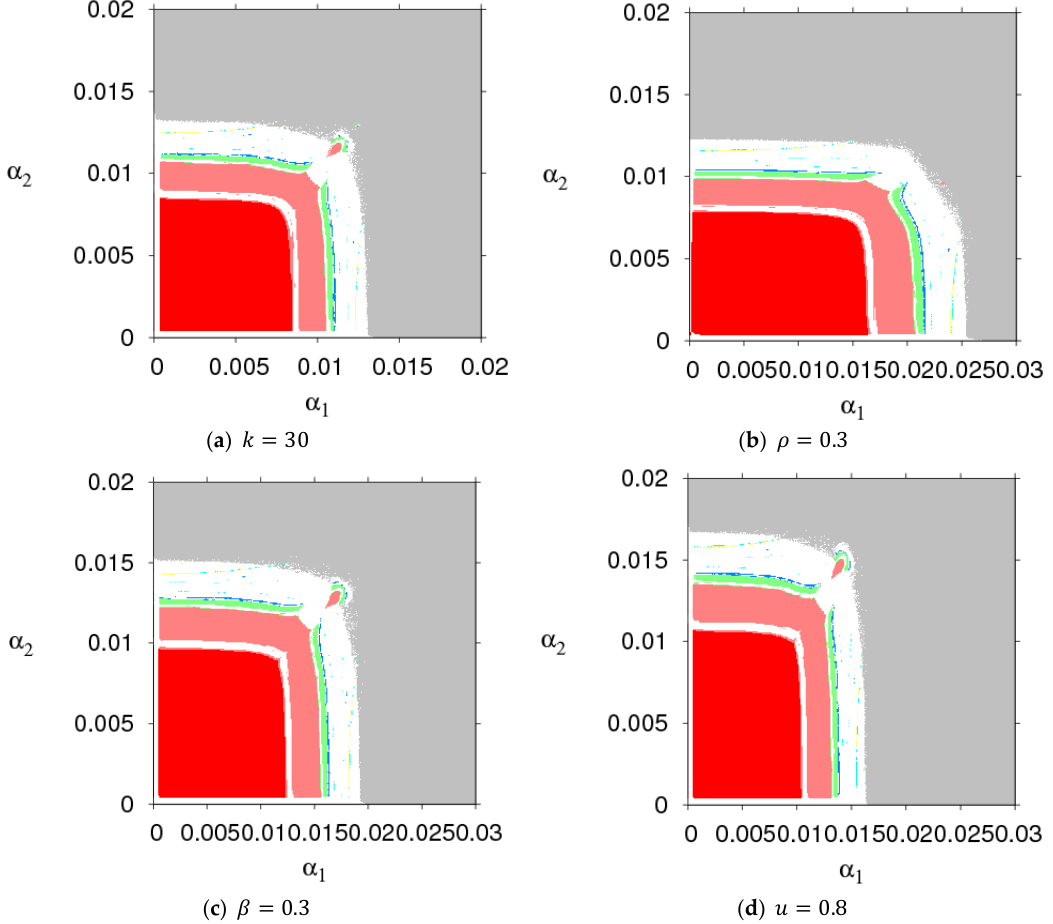
Figure 3. The parameter basins of dynamic System (7) under different parameter values.